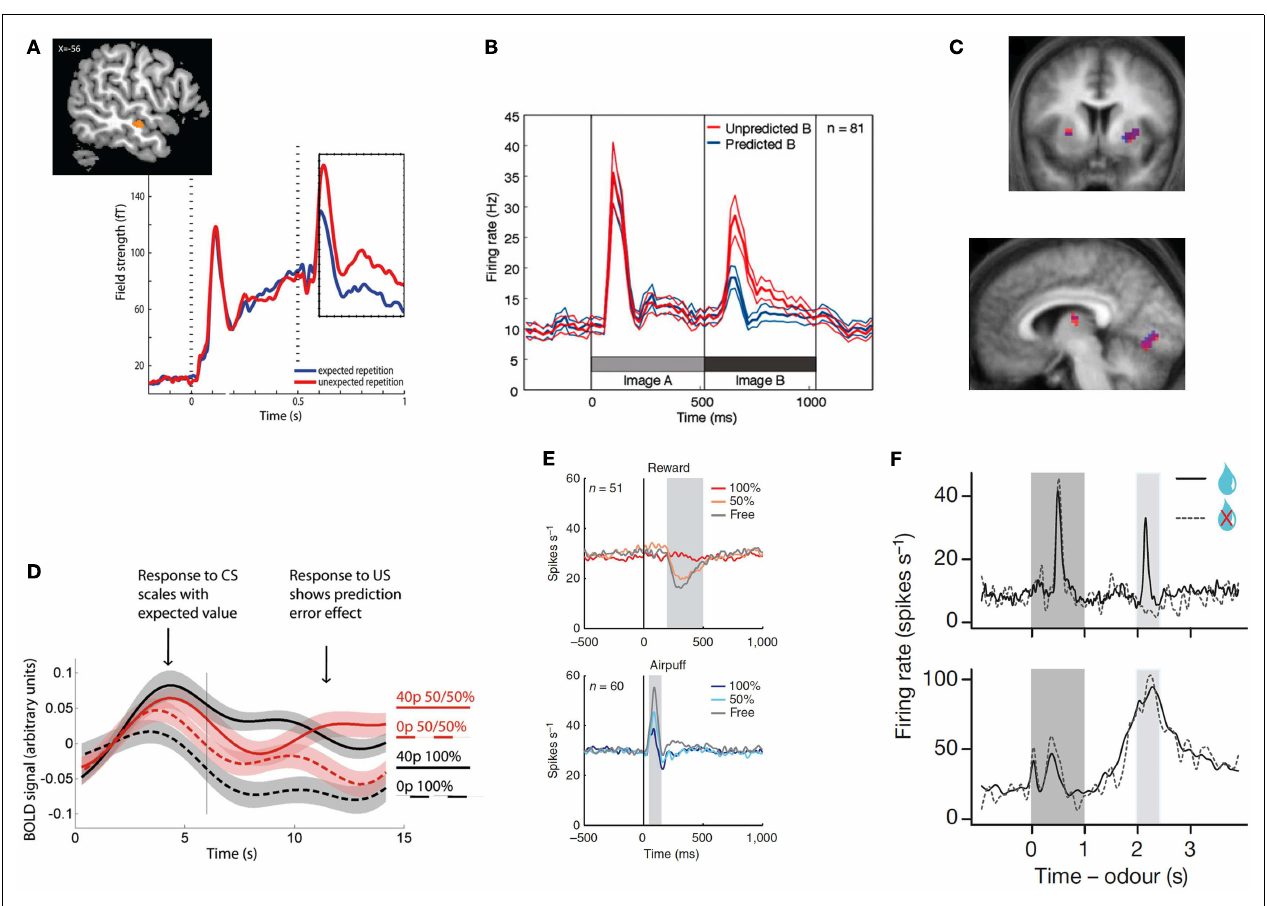
permission from Elsevier. (E) Single-unit recordings: neurons in the lateral habenula signal punishment prediction errors, as they fire stronger for outcomes that are worse than expected, and less for outcomes that are better than expected, both in the rewards (top) and punishment (bottom) domain. Reprinted by permission from Macmillan Publishers, Ltd: nature Neuroscience (Matsumoto and Hikosaka, 2009a), copyright (2009). (F) Single-unit recordings.Top panel: firing rate of dopaminergic neurons in theVTA at the time of the reward signaling cues (dark gray), and presentation versus omission of reward (light gray block). Bottom panel: GABAergic neurons fire in response to the predictive peaking at the time of the predicted reward, independently of the nature of the outcome (reward or no reward). Reprinted by permission from Macmillan Publishers, Ltd: nature (Cohen et al., 2012), copyright